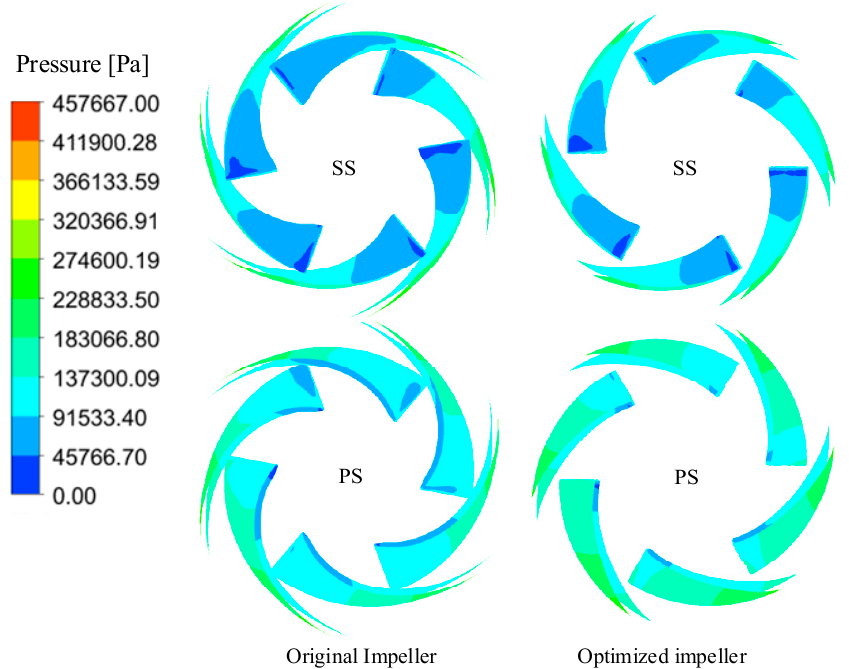
Figure 18. Comparison of static pressure distribution in impeller blade surface. Processes 2019 , 7 , x FOR PEER REVIEW